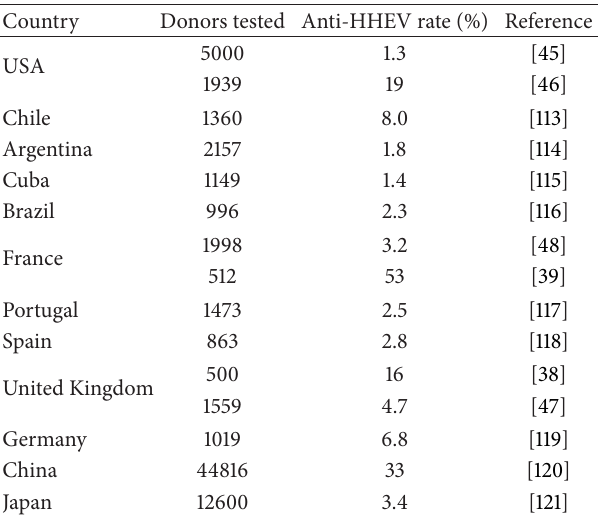
Table 5: Results from selected studies reporting the prevalence of anti-HHEV among blood donors in the World.